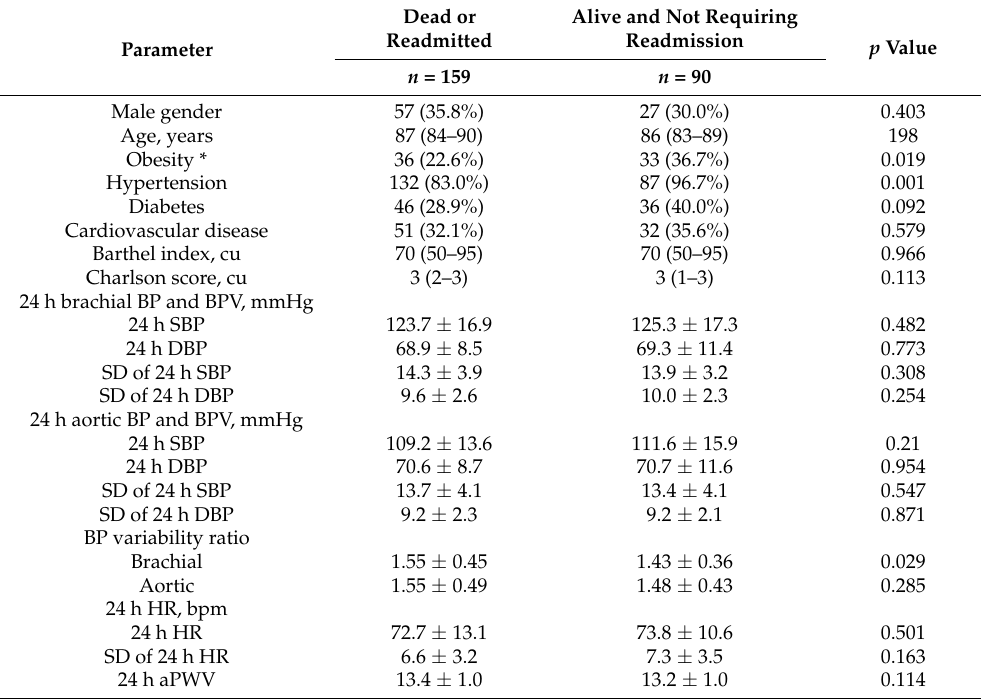
Table 3. Differences in clinical parameters, BP estimates, aortic pulse wave velocity (aPWV), and blood pressure variability (BPV) in patients with or without the combined endpoint of death or readmission during the year of